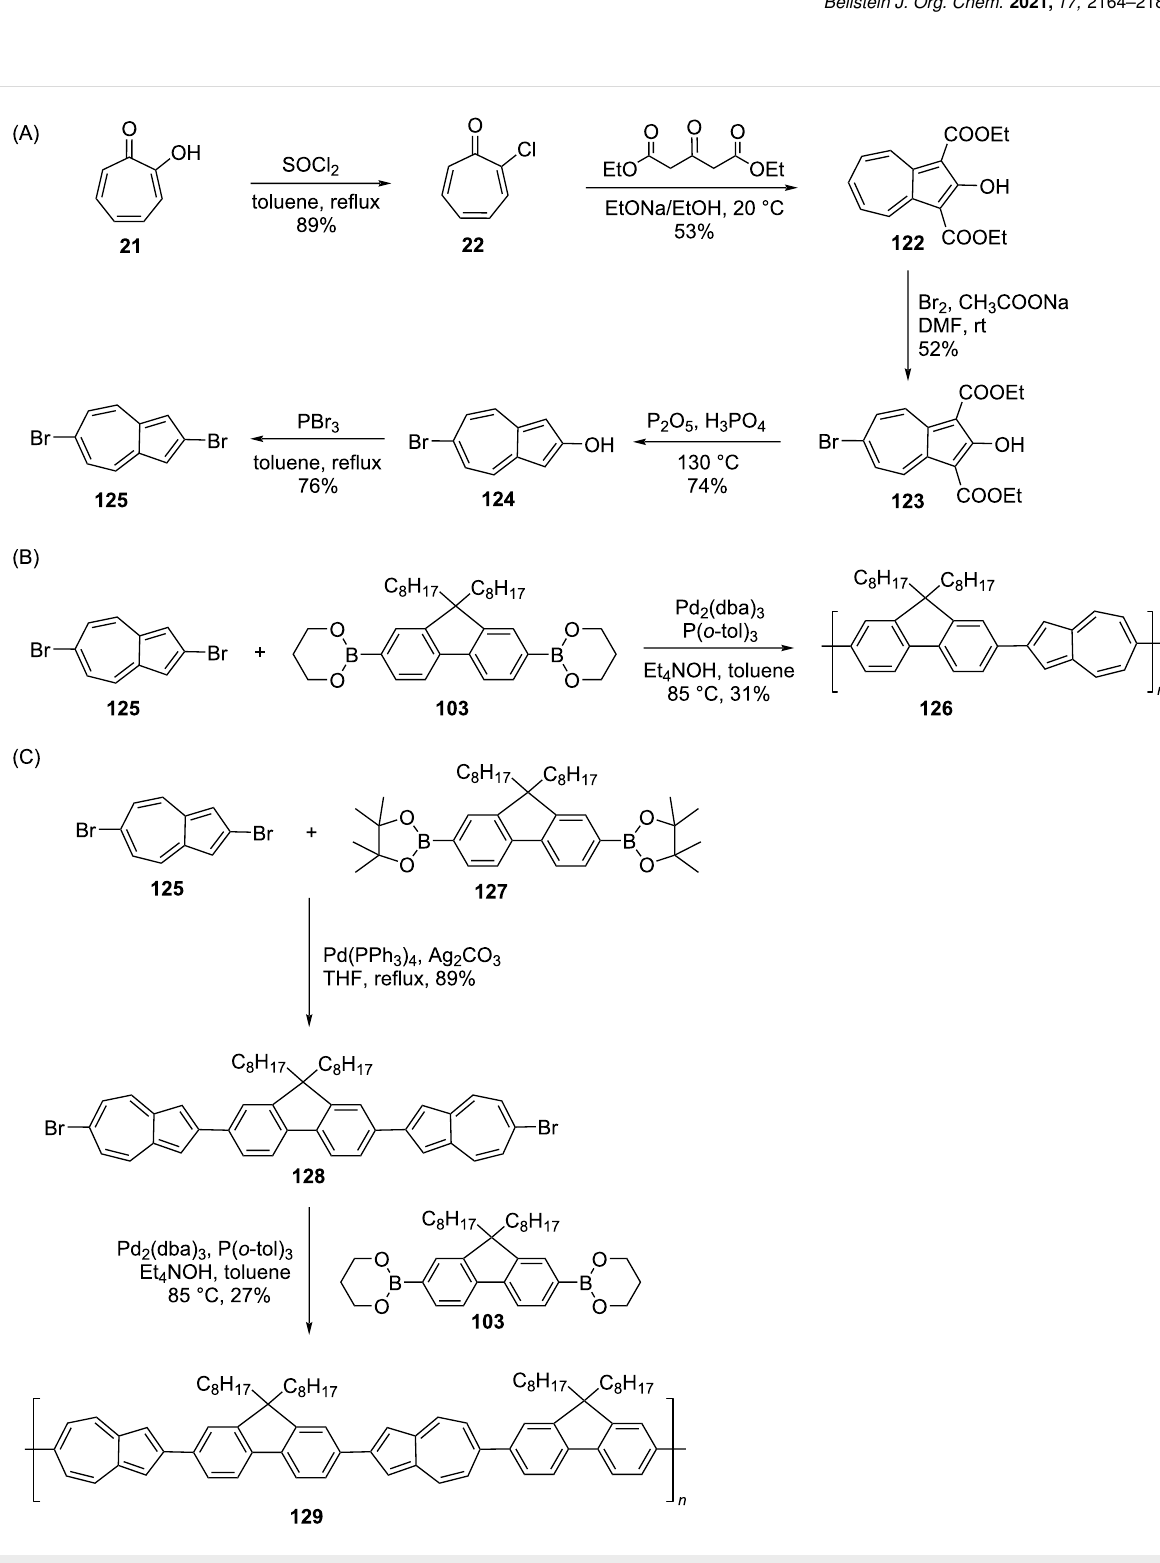
terial to make these polymers was 2,6-dibromoazulene ( 125 ), dibromoazulene ( 125 ) with 2,2’-(9,9-dioctyl-9 H -flourene-2,7- diyl)di(1,3,2-dioxaborolane) ( 103 ) furnished the polymer 126